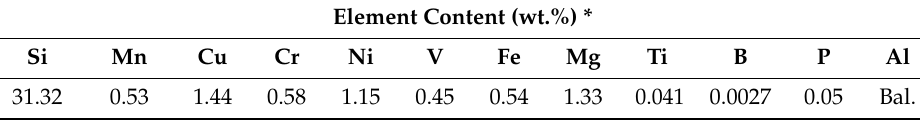
Table 1. Chemical composition of hypereutectic aluminum-silicon alloy [13].